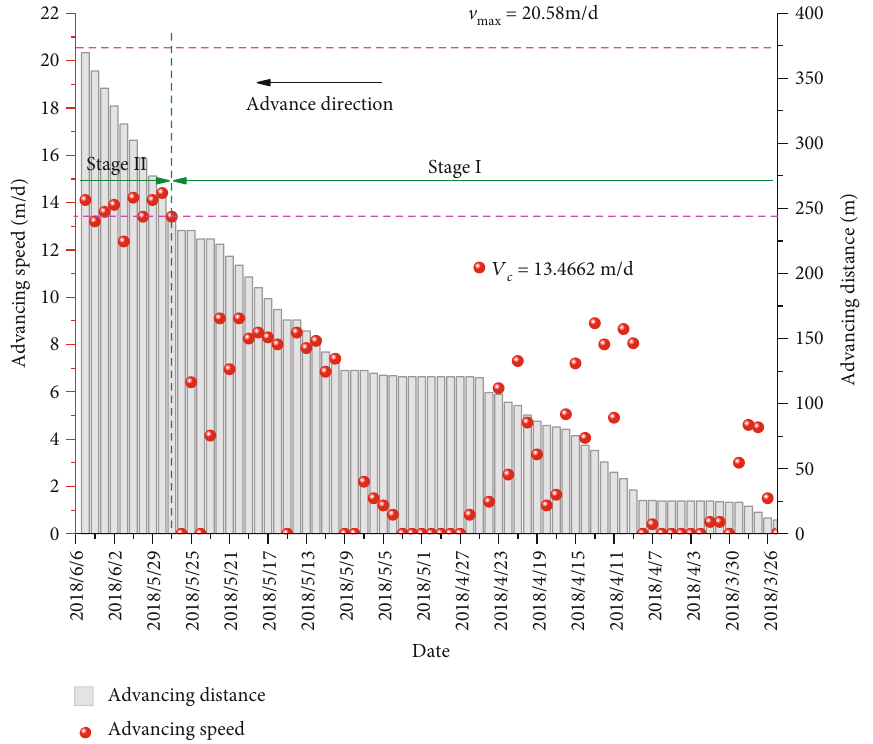
Figure 11: Statistics of the advancing speed and advancing distance of panel